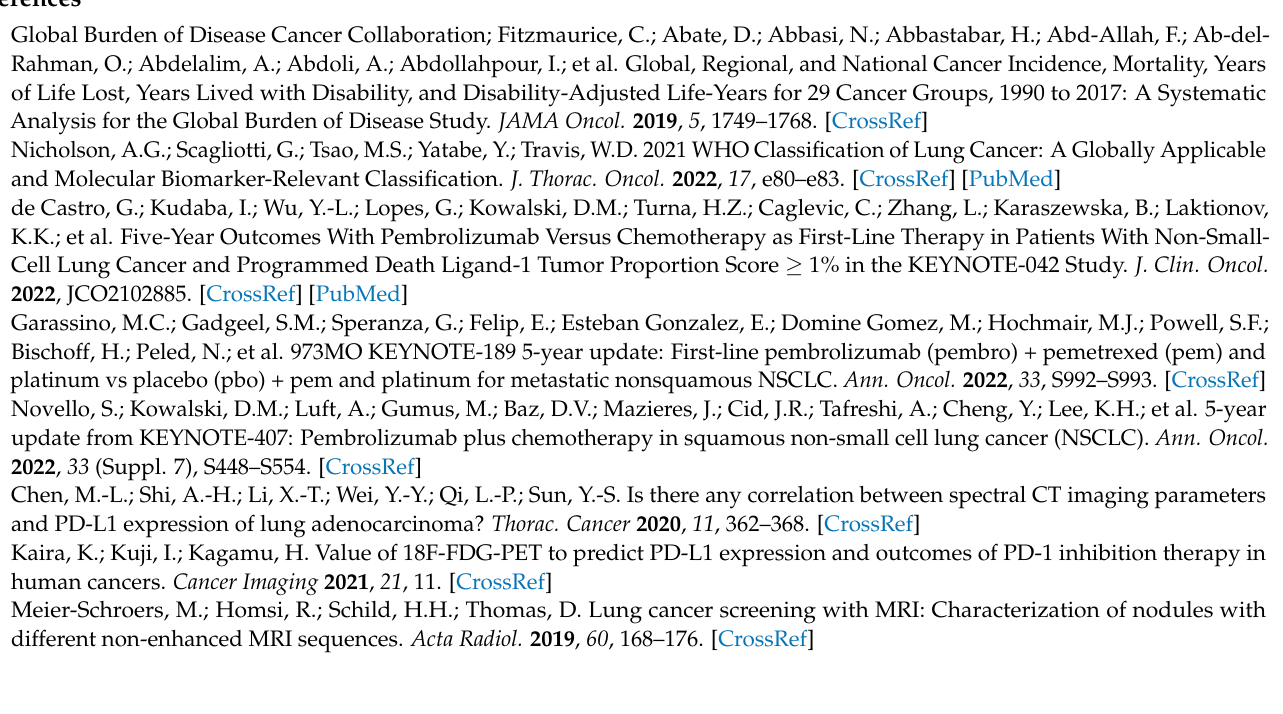
a different algorithm. Analysis on 19 patients.; Figure S2. Correlation heatmap for freehand ROIs between the 22 IVIM-DWI parameters and the expression of PD-L1. Each row represents a different algorithm. Analysis on 21 patients.; Table S1: Table with results for fixed-size ROIs for algorithms 0, 1, 2, and 3. G0 refers to non-expression PD-L1 and G1 refers to the positive expression of PD- L1.; Table S2: Table with results for free-hand ROIs for algorithms 0, 1, 2, and 3. G0 refers to non-expression PD-L1 and G1 refers to the positive expression of